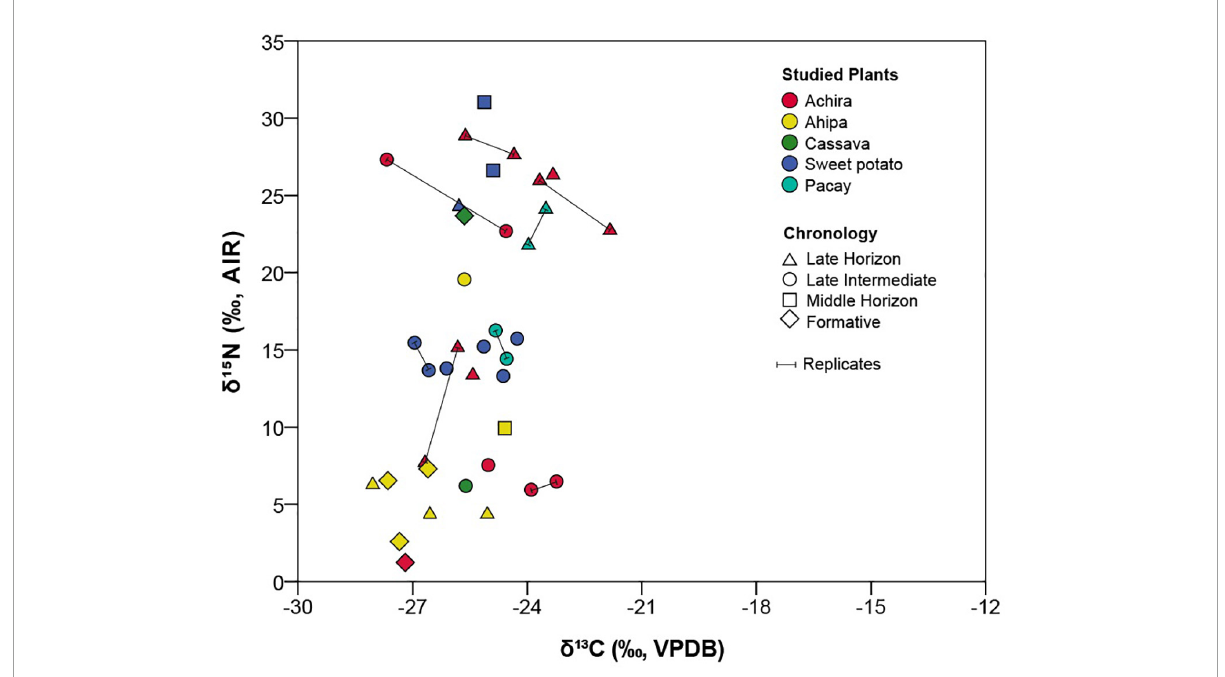
FIGURE5 Bivariate plot including the carbon and nitrogen stable isotopes results organized by study plants and chronology.